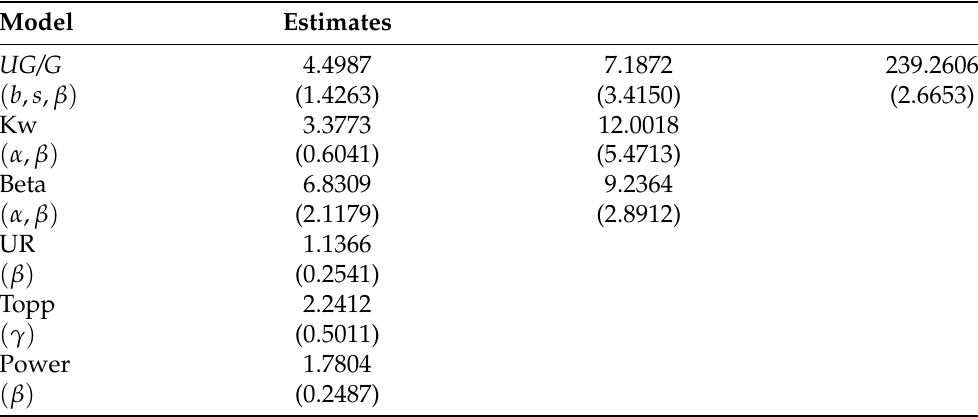
Table 11. Estimates (MLEs and SEs under parentheses) associated to the model parameters for the flood level data set.